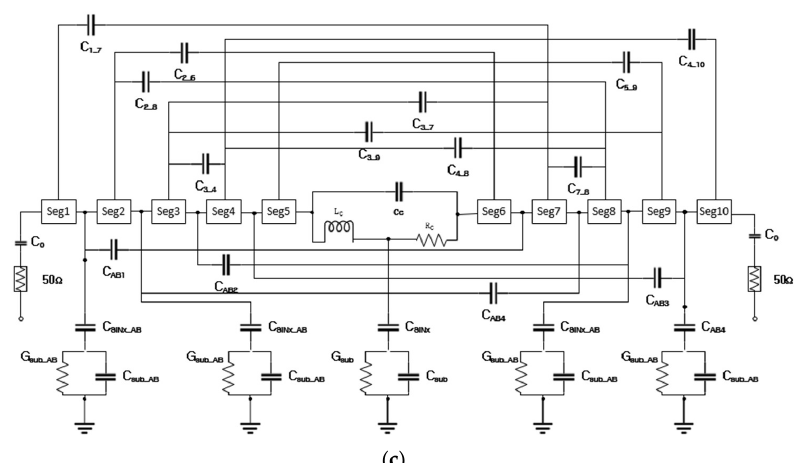
Figure 2. Equipment circuit model of the proposed BPF: ( a ) number of segment boxes of the proposed BPF; ( b ) π-type lumped-element model inside the segment box; ( c ) equivalent circuit model of the proposed BPF.